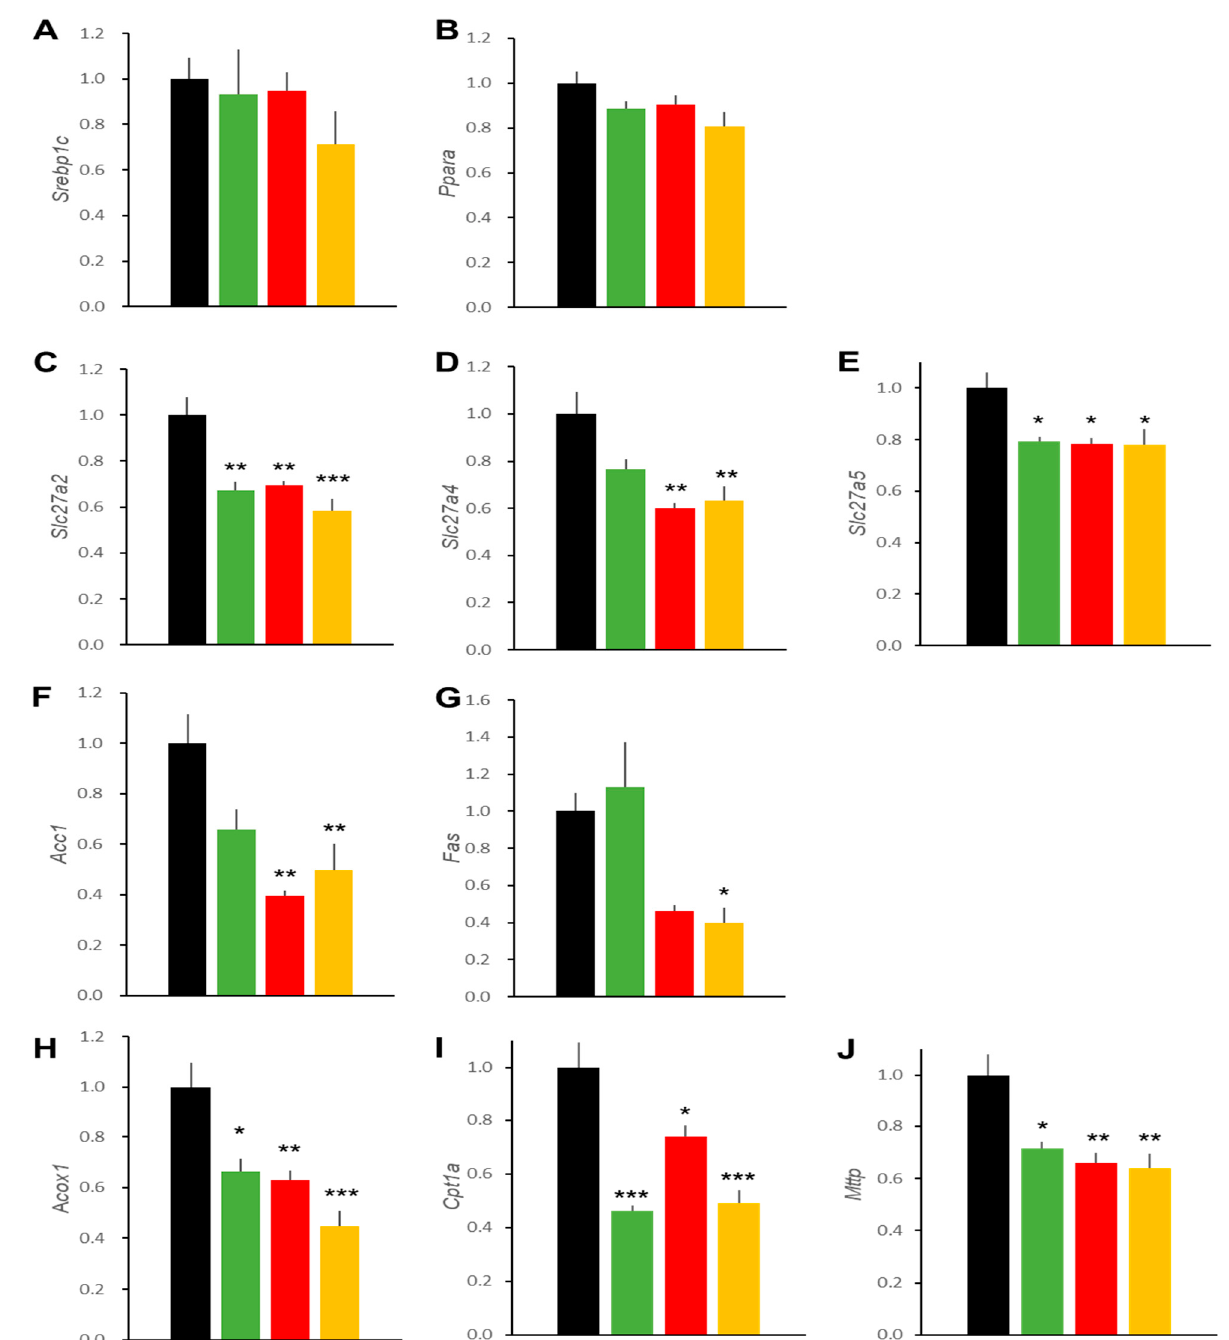
Figure 5. Effects of treatments on hepatic expressions of genes related to lipid metabolism in DIO mice. Expressions of two master regulator genes of hepatic lipid metabolism: Srebp1c ( A ) and Ppara ( B ). Genes important for fatty acid uptake: Fatp2 ( C ), Fatp4 ( D ), and Fatp5 ( E ). Genes important for fatty acid synthesis: Acc1 ( F ) and Fas ( G ), and for fatty acid oxidation: Acox1 ( H ) and Cpt1a ( I ). Gene important for TG excretion: Mttp ( J ). Data represent mean ± SE, n = 6, * p < 0.05, ** p < 0.01, *** p < 0.001 vs. Control group.